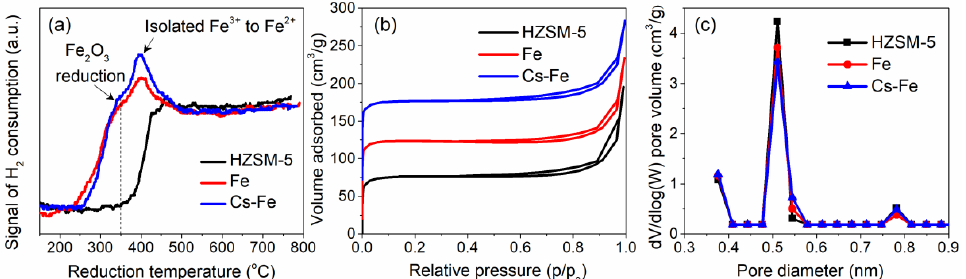
Figure 7. Properties of Cs-Fe-HZSM-5 catalyst analyzed by ( a ) H 2 -TPR, ( b ) N 2 adsorption/desorption isotherms and ( c ) pore size distribution. Note: In ( b ), the offsets of Y axis for HZSM-5, Fe and Cs-Fe were − 30, 20 and 70, respectively.